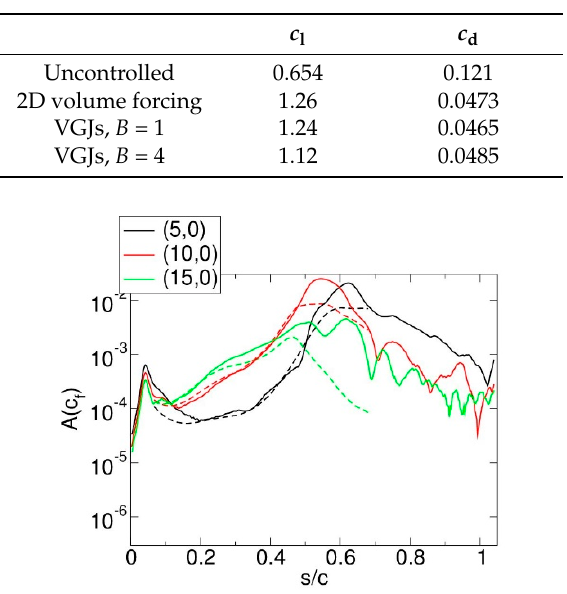
Figure 27. Top surface skin friction coefficient Fourier amplitudes for 2D volume forcing (dashed lines: LST, solid lines: simulation).